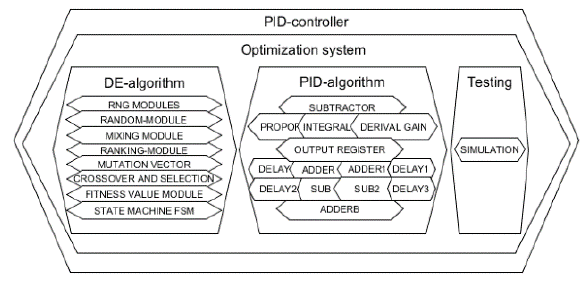
Figure 3: The Architecture of the PID-controller